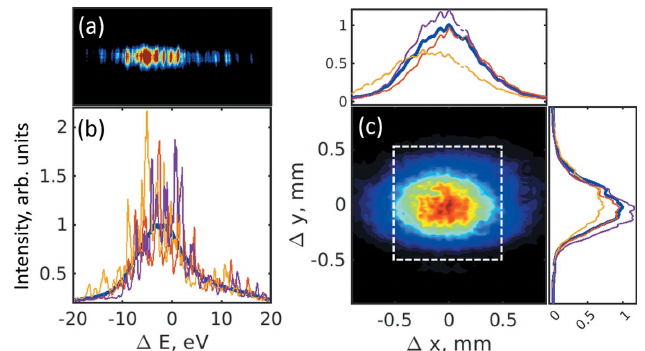
Figure 2 Spectral and spatial intensity distributions for the SASE operating conditions with the 180 pC bunch charge. ( a ) Typical 2D spectral intensity distribution of a single pulse in the SASE mode measured by the Andor CCD detector after subtraction of the dark images. ( b ) Projection of several individual pulses in the vertical direction and an average spectrum (blue line). ( c ) Average spatial intensity distribution in the SASE mode measured by the Hamamatsu detector. The region of interest for the correlation analysis in the spatial domain is shown in ( c ) by the white dashed square. A projection of individual pulses as well as an average intensity distribution (blue curve) in the horizontal and vertical directions is also shown in panel ( c ).